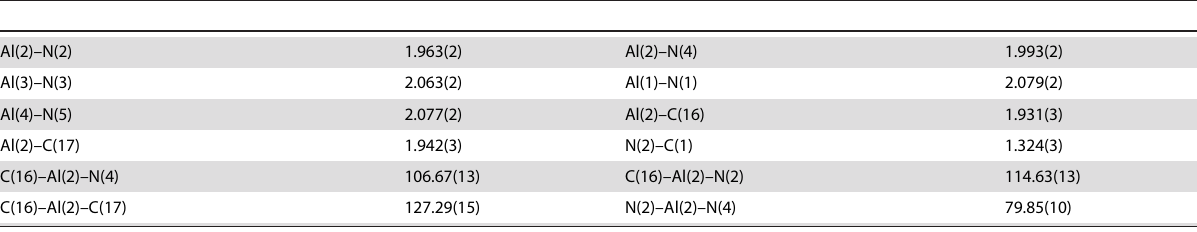
Table 2. Selected bond lengths (A˚) and angles (deg) for 1